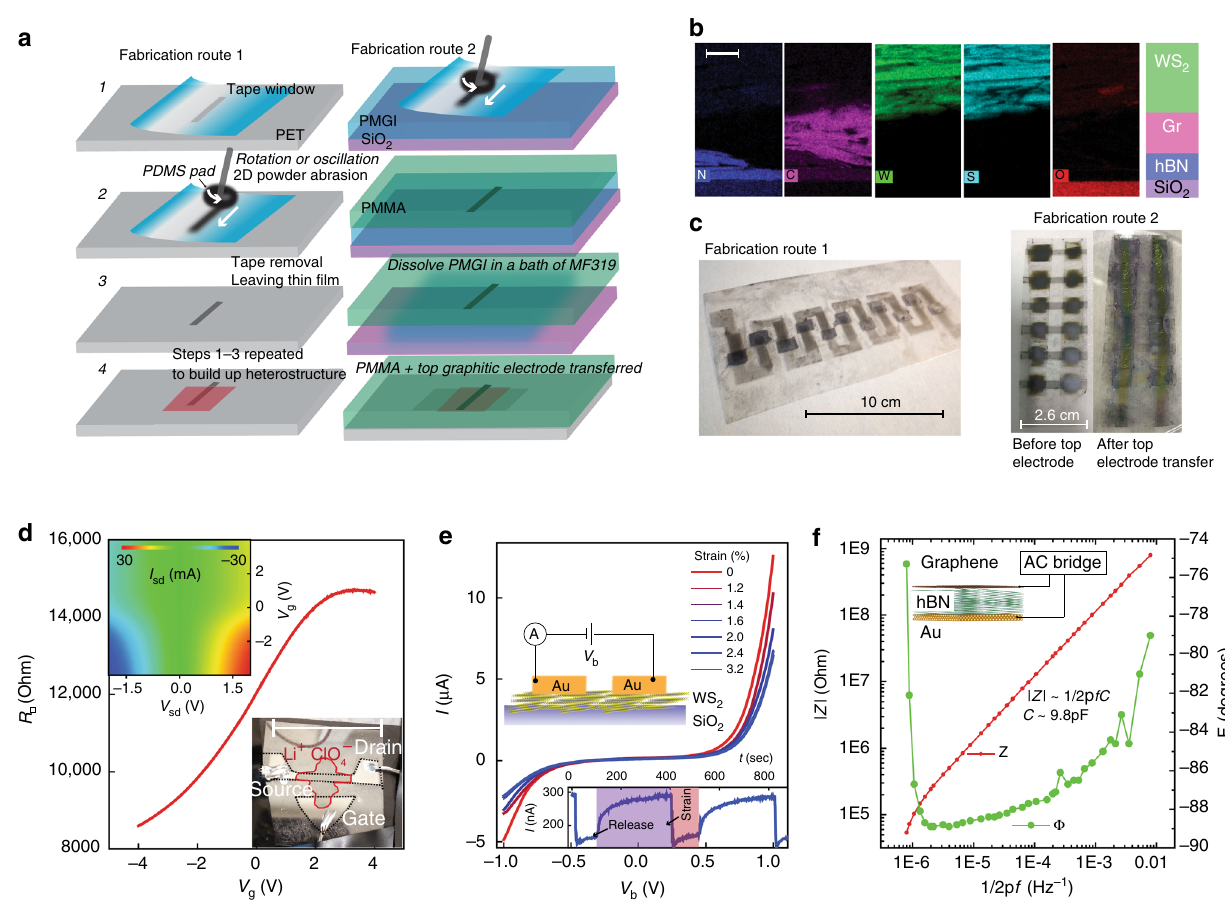
Fig. 1 Thin fi lms produced through powder abrasion. a Fabrication routes used to produce heterostructures through mechanical abrasion of vdW powders via a direct write method. b STEM-EDS elemental mapping of an abraded vertical heterostructure (scale bar = 400 nm). c Left: An example of multilayered vertical junction photodetectors based on a graphite – WS 2 – graphite architecture produced via fabrication route 1. Right: The same architecture as the left micrograph but this time following fabrication route two, with the top graphitic electrode transferred from PMGI, which leads to a higher device yield. d Gate dependence of the channel sheet resistance for a tape thinned graphitic channel using a LiClO 3 electrolyte (scale bar = 2.5 cm). Top left inset: Contour map of the I sd – V sd for different applied gate voltages. Bottom right inset: Optical image of the device. e Typical I – V b for a 5 mm × 0.025 mm two terminal planar device based on WS 2 fi lms with a mean fi lm thickness of 1 μ m for different levels of applied uniaxial tensile strain. Inset: V b is held at 0.5 V and the device is subjected to reversible uniaxial tensile strain. f Impedance spectroscopy for a hBN dielectric capacitor produced using a 5 μ m thick hBN fi